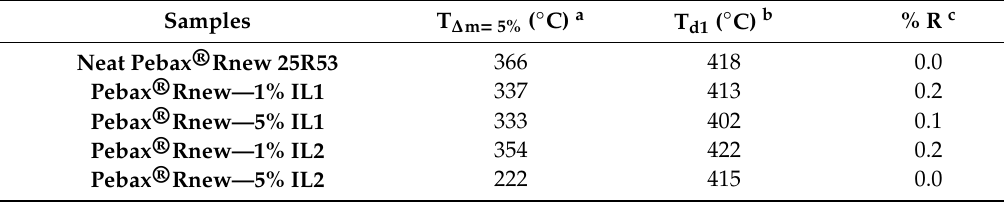
Table 2. Thermogravimetric data of neat Pebax ® Rnew and its